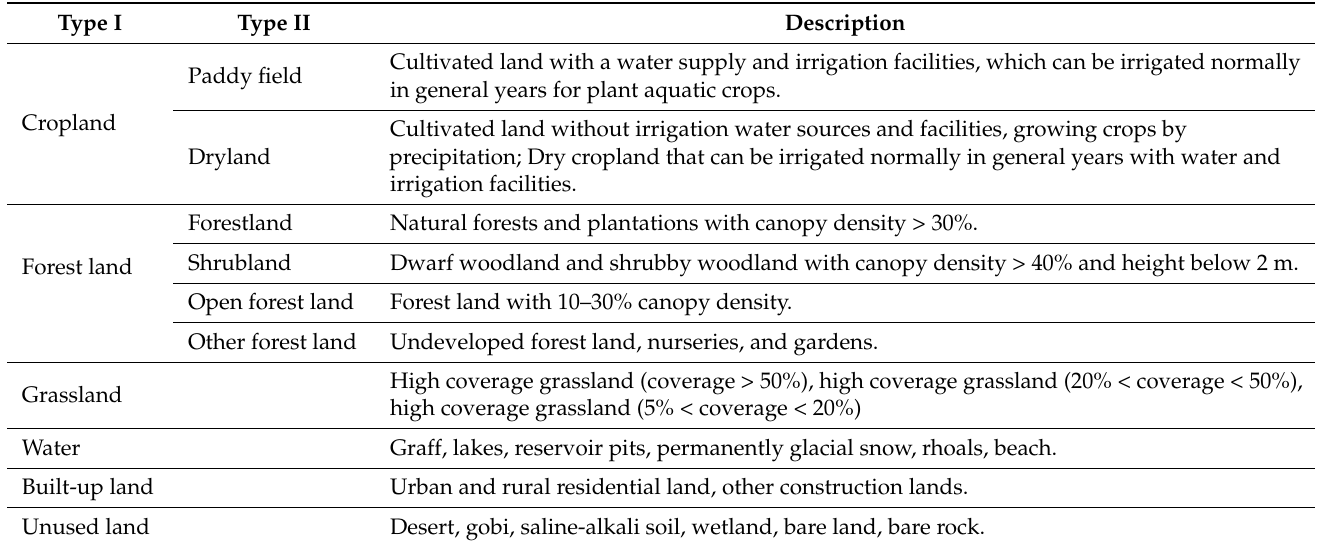
Table 3. The classification and description of six types of land use.